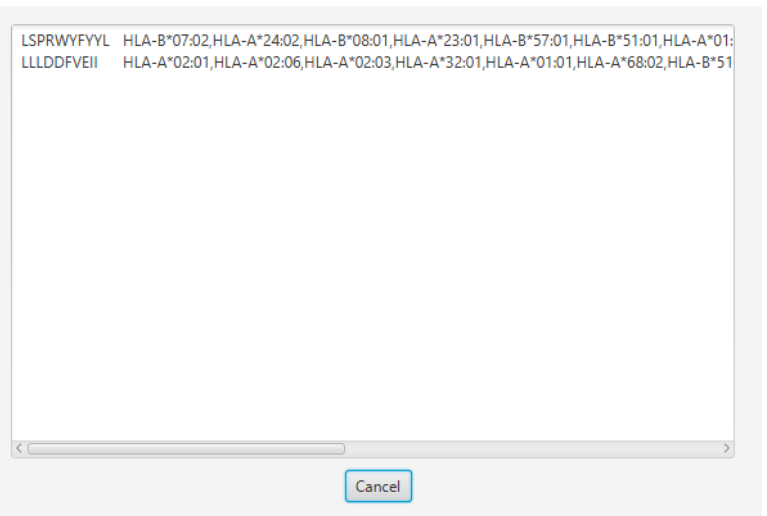
Figure 5. Optimization screen of PCOptim GUI system. Optimized data can be copied and pasted into a.txt file for population coverage prediction or pasted into a spreadsheet to save.